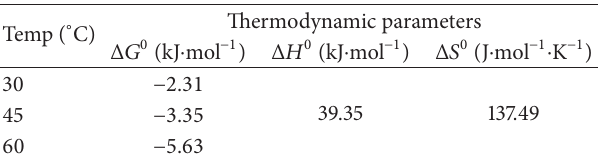
Table 6: Thermodynamic parameters for the synthesized matrix. Temp ( ∘